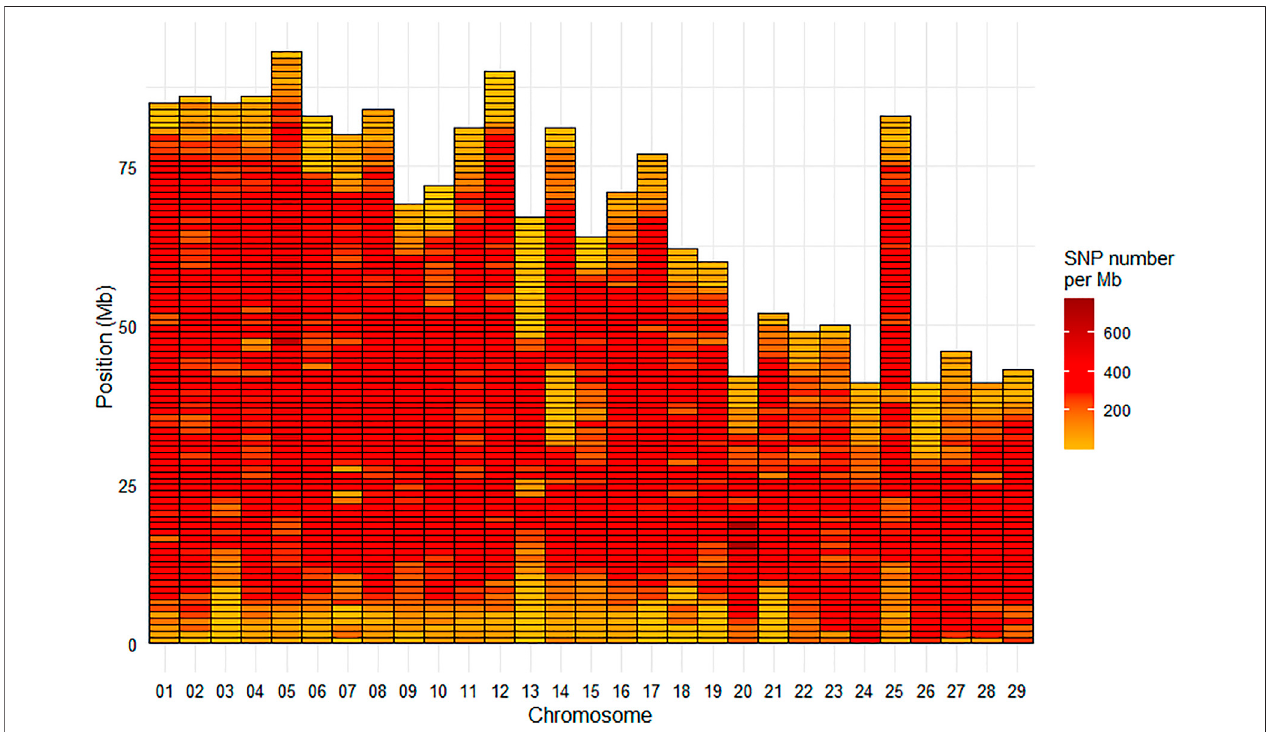
FIGURE 2 | Marker density per Mb for the HD Trout Affymetrix array with 664,503 SNPs positioned on the 29 chromosomes of the Swanson genome reference.